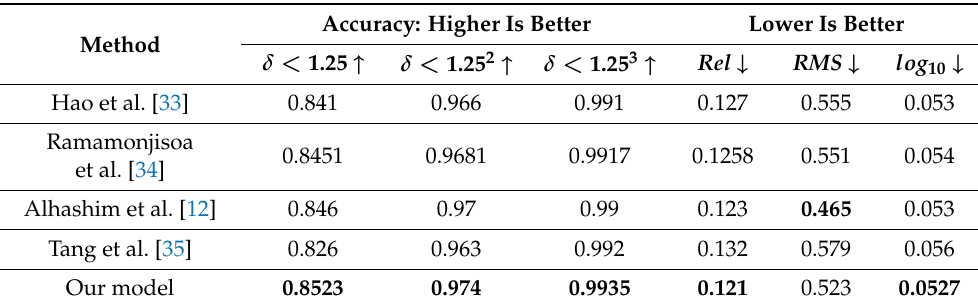
Table 3. Quantitative results of the proposed model and four depth estimation methods on the NYU Depth v2 dataset.